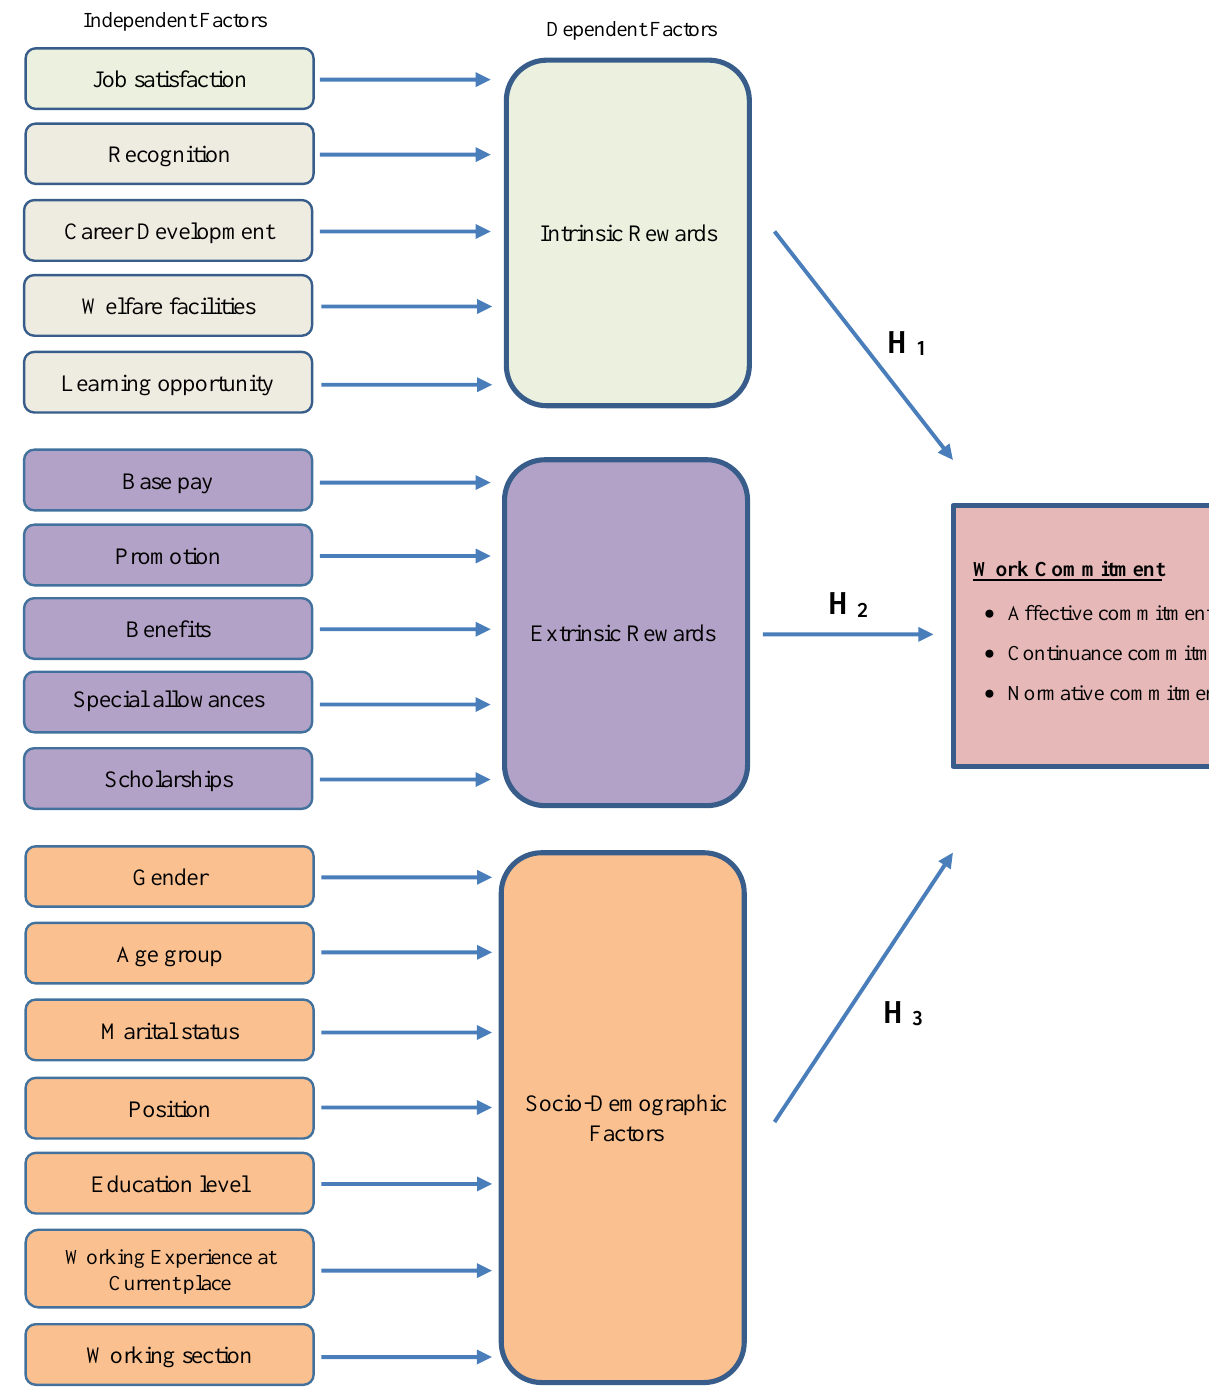
Figure 1. Conceptual